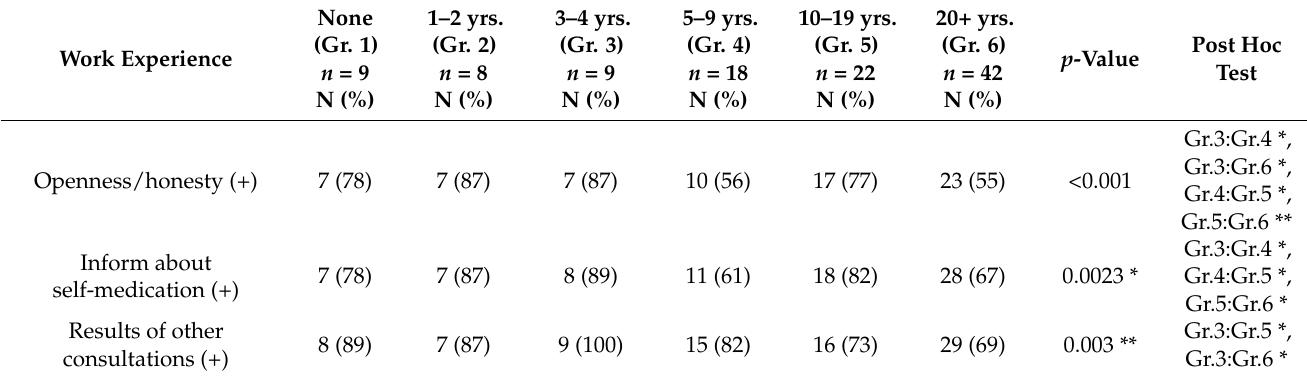
Table 5. Influence of the GP’s work experience on their perception of the patient’s